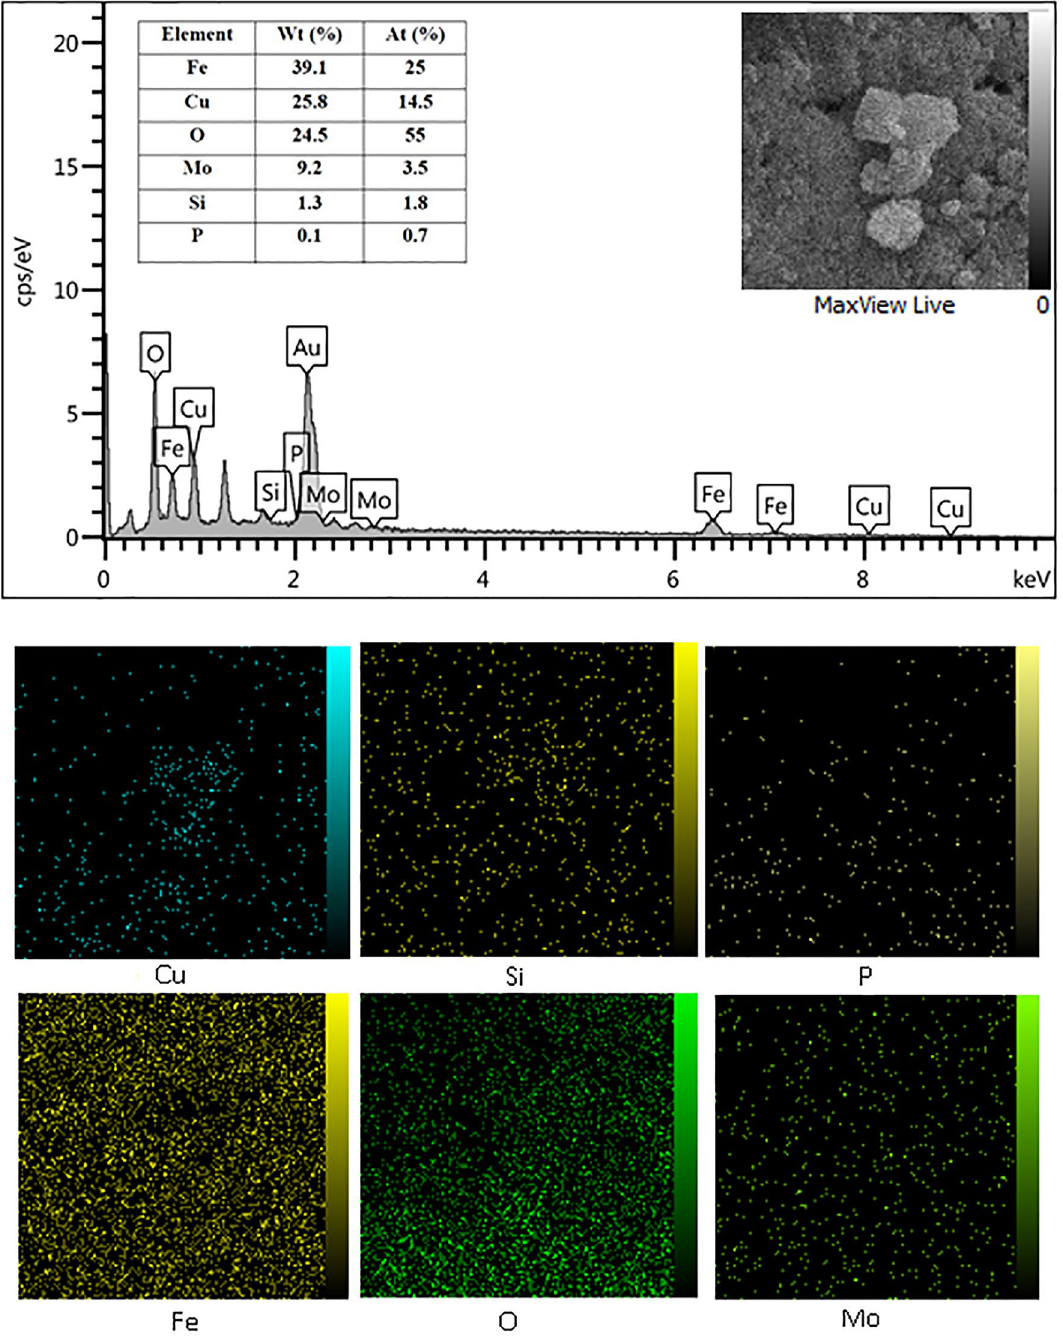
Figure 8. EDS of Fe 3 O 4 @SiO 2 -PMA-Cu and elemental mapping of Fe, O, Si, P, Mo,